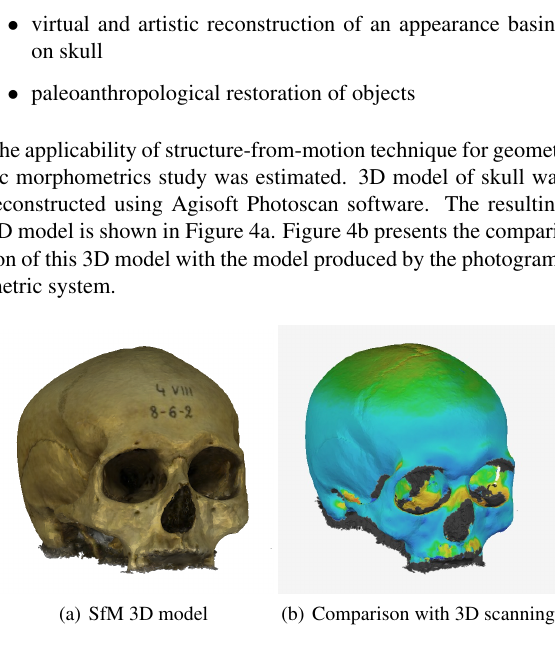
(b) and a fragment of the 3D model acquired with high resolution (c) (”micro” configuration of the photogrammetric system).